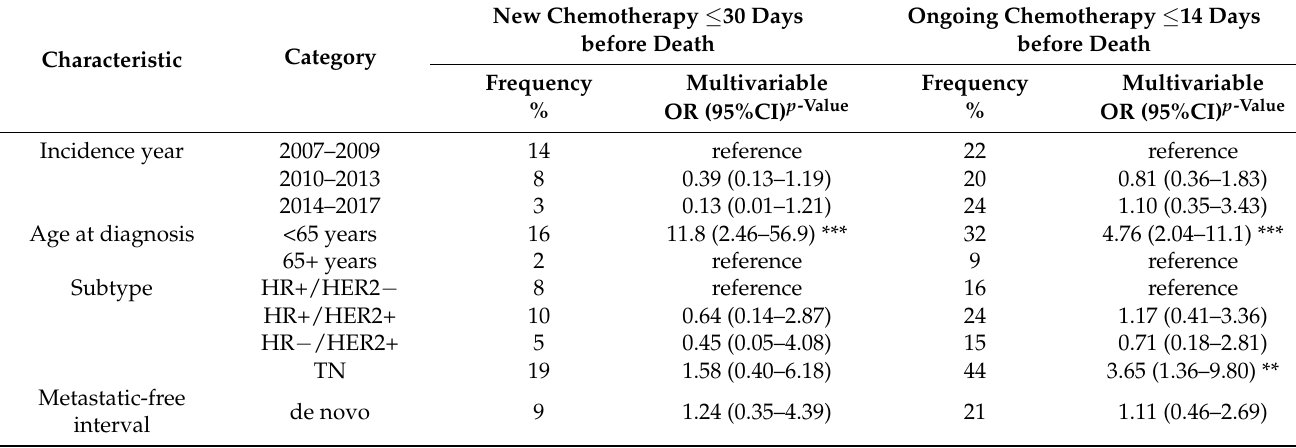
Table 4. Characteristics associated with chemotherapy use near the end of life, n = 200 #